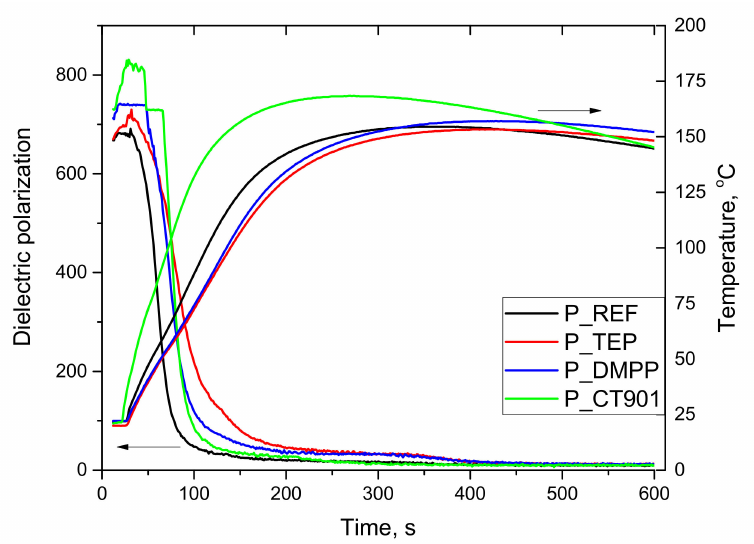
Figure 1. Influence of flame retardants addition to the reference system on dielectric polarization and temperature during the PUR foaming process without the addition of